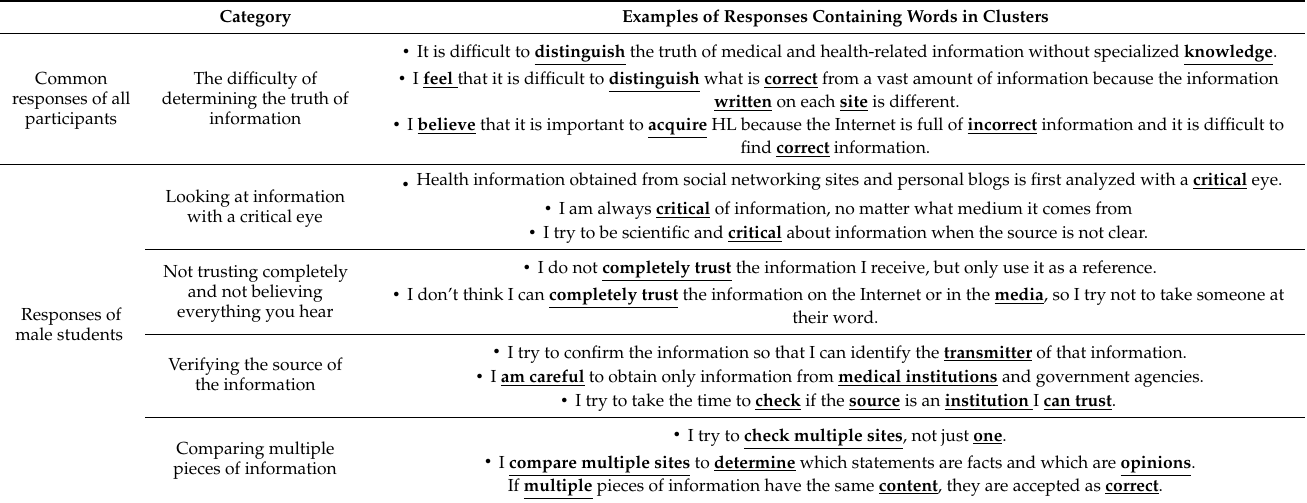
Table 6. Content categorization of details in the open-ended responses.